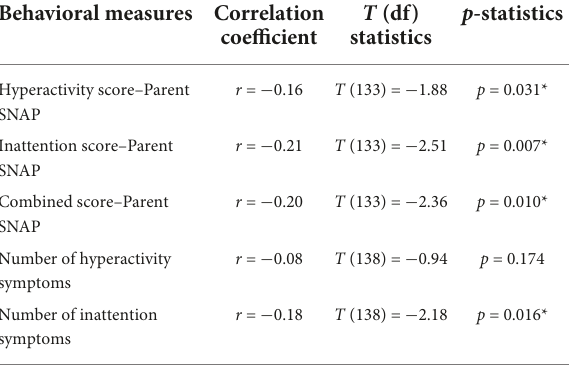
TABLE 2 Links between BrainAGE index and ADHD symptom